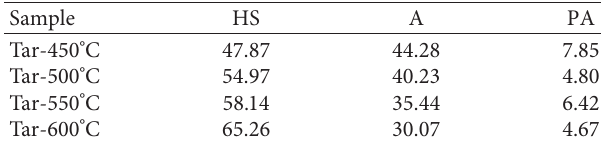
Table 2: Solvent extraction results of residual pyrolysis oil at different pyrolysis